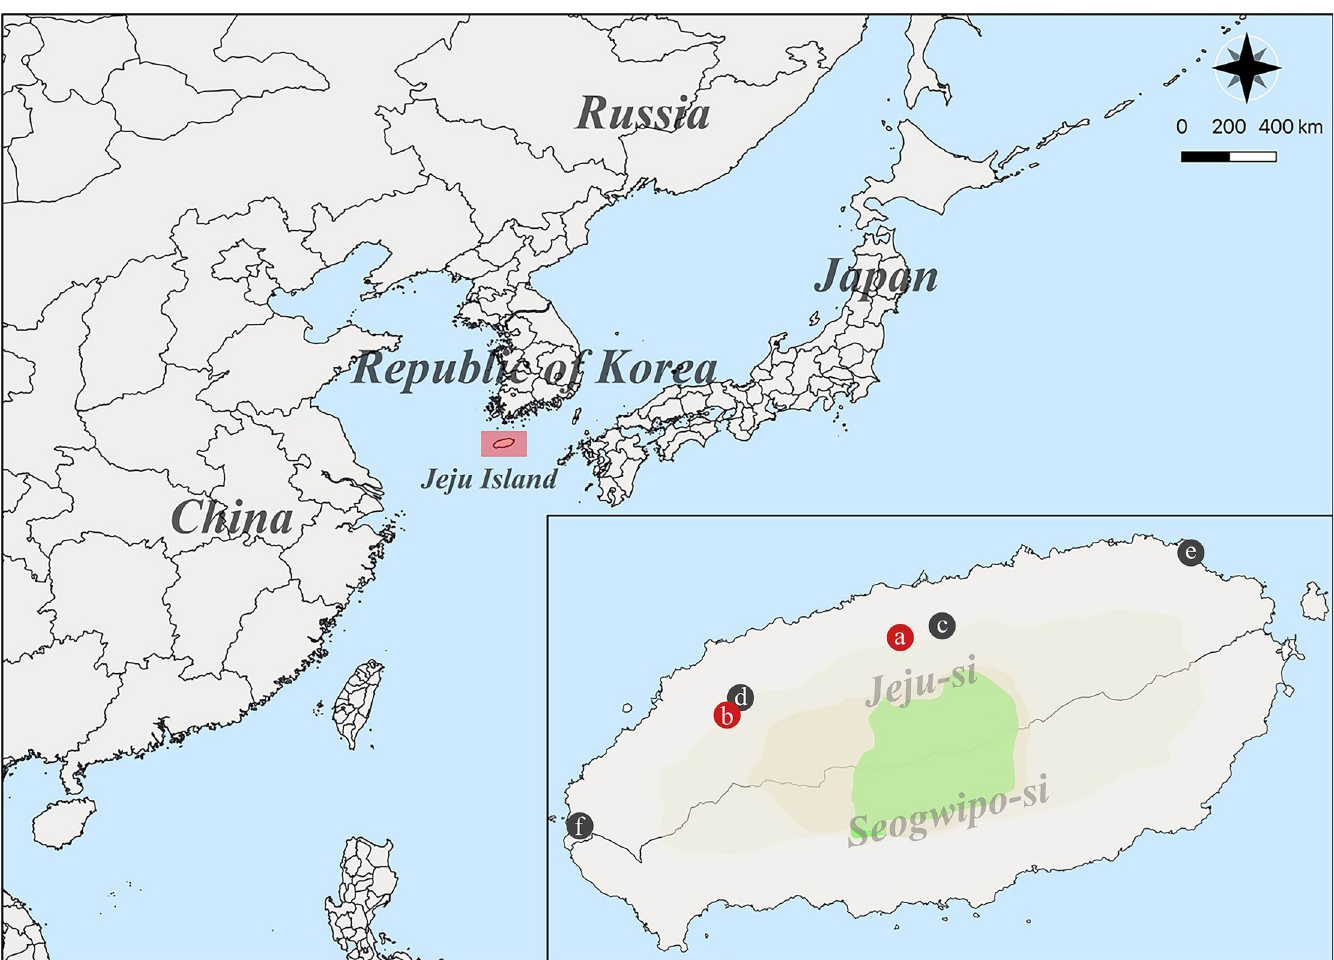
Fig 1. Geography of trapping sites of Hantaan virus (HTNV) collected on Jeju Island, the Republic of Korea. A geographic map shows different trapping locations where small mammals were captured on Jeju Island from 2018 to 2020. The red circles indicate the HTNV RNA positive areas: a, Ora-dong; b, Bongseong-ri in Jeju-si, respectively. The black circle represents the regions where no HTNV RNA was identified: c, Ara-dong; d, Aewol-eup; e, Haengwon-ri; f, Youngsu-ri. The Quantum Geographical Information System (QGIS) 3.10 for Mac was used to create the map.